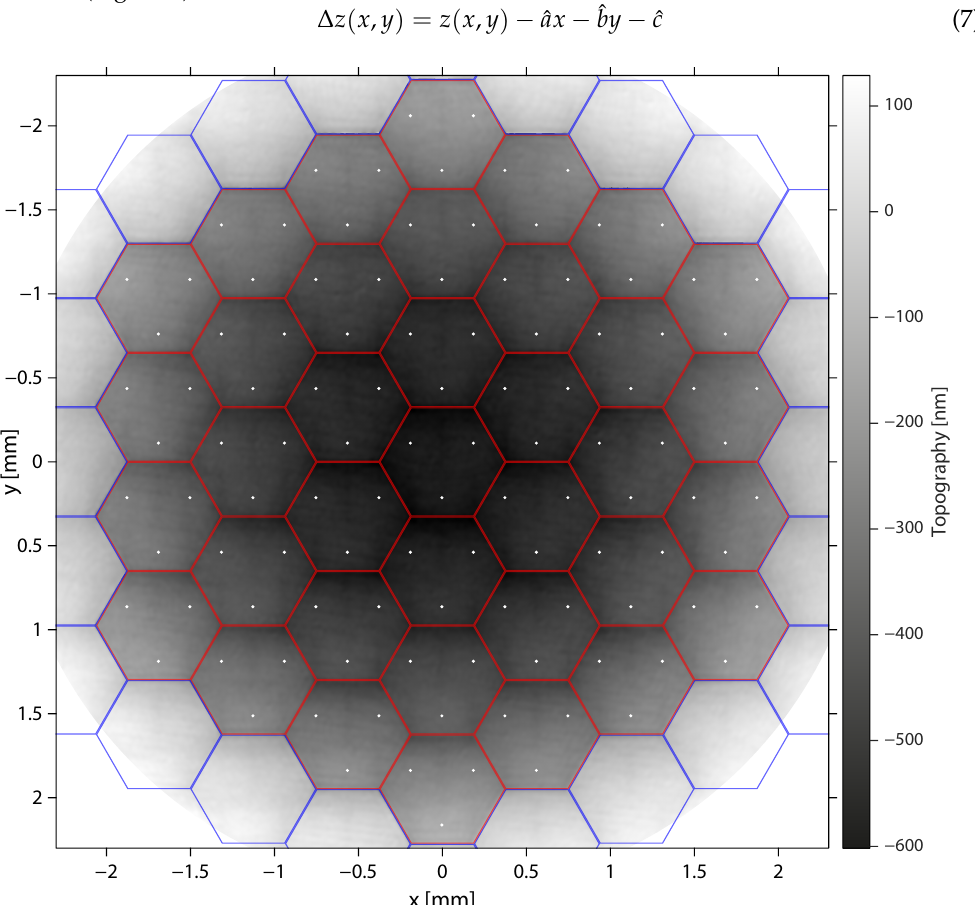
Figure 5. Referenced topography ∆ z ( x , y ) obtained from the phase map shown in Figure 4. Red hexagons indicate the 37 active segments of the deformable mirror and white dots the attachment points of its 111 actuators. Blue hexagons outline inactive mirror